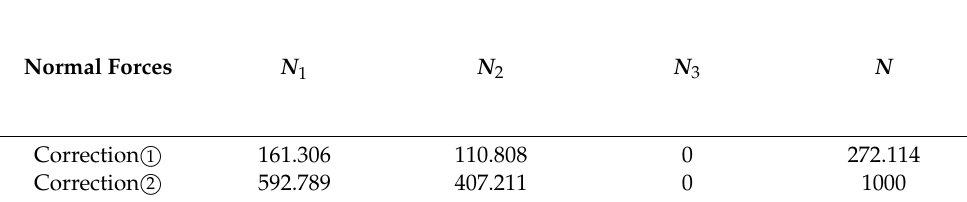
Table 5. Normal forces of discrete areas of translation method ( the 3rd discrete, and the maximum pressure is raised by about four